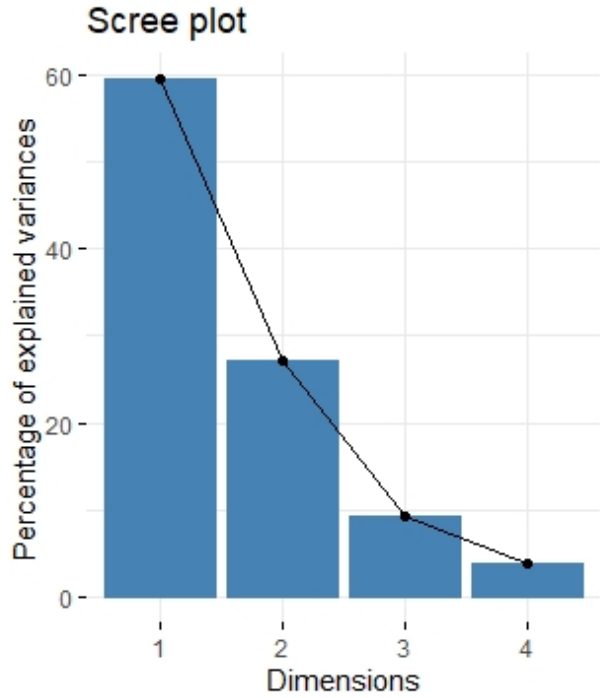
Figure 7. Correlation between HHLA2 tumor concentration and trophic factor1 from principal component analysis containing HGF, M-CSF, b-NGF, SCGF-b, IL-7, FGFbasic, G-CSF, PDGF-bb, VEGF, GM-CSF.